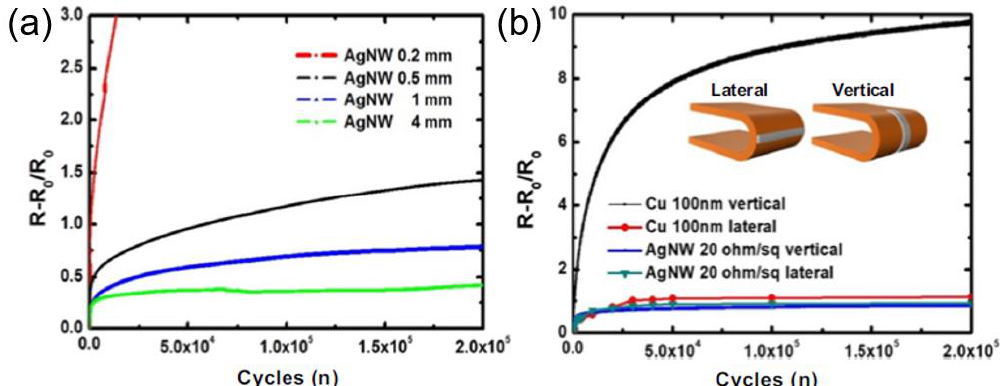
Figure 13. Resistance change of ( a ) Ag NW networks with different widths. ( b ) Response of Cu thin films and Ag NW networks in terms of directional resistance variations after cyclic bending. The directions of resistance: perpendicular to the lateral pattern (left) and parallel to the vertical pattern (right). Reproduced with permission from [49]. Copyright 2019 Elsevier.